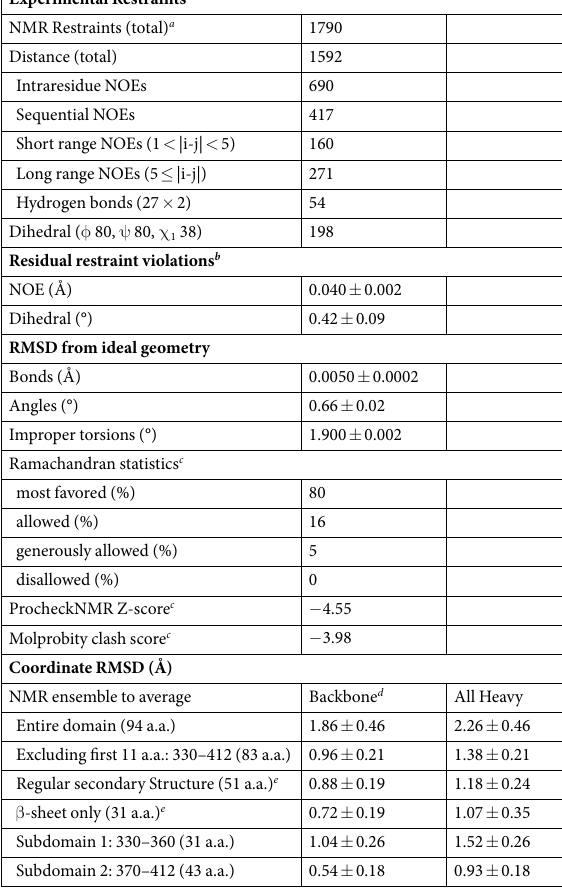
To investigate structure similarity relationships for HlyIIC we performed a structural homology search using the Dali server 26 . The search failed to identify homologs, with the closest hit having a Z-score of 1.8 that is not considered significant 26 . The closest hit was a portion of formyltetrahydrofolate deformylase (PDB code 3NRB), which gave an RMSD of 3.0 Å to HlyIIC. Inspection of this structure, however, showed that the two proteins do not share the same topology. We thus conclude that HlyIIC represents a previously uncharacterized, novel protein fold.